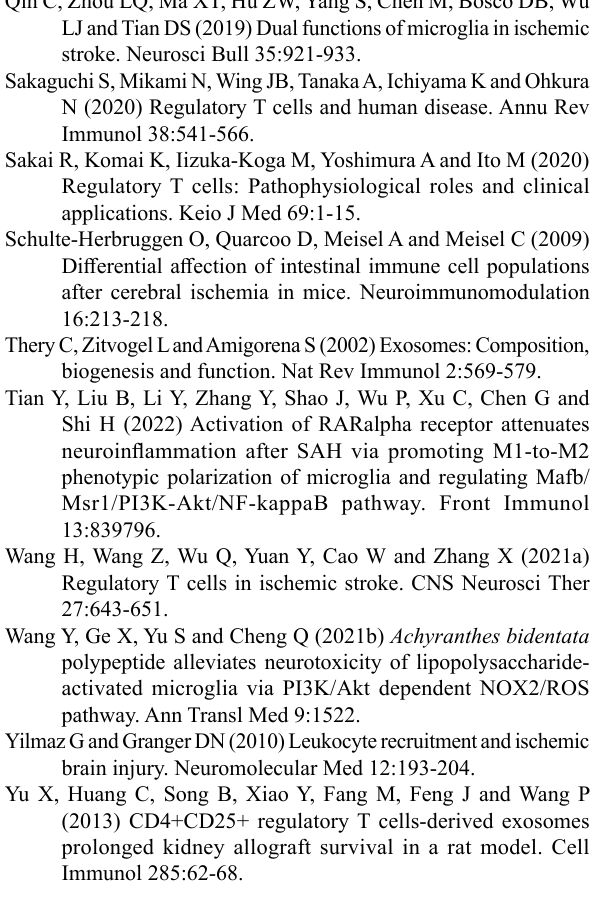
Figure S1 – Cell viability of BV-2 microglia incubated with the culture medium of